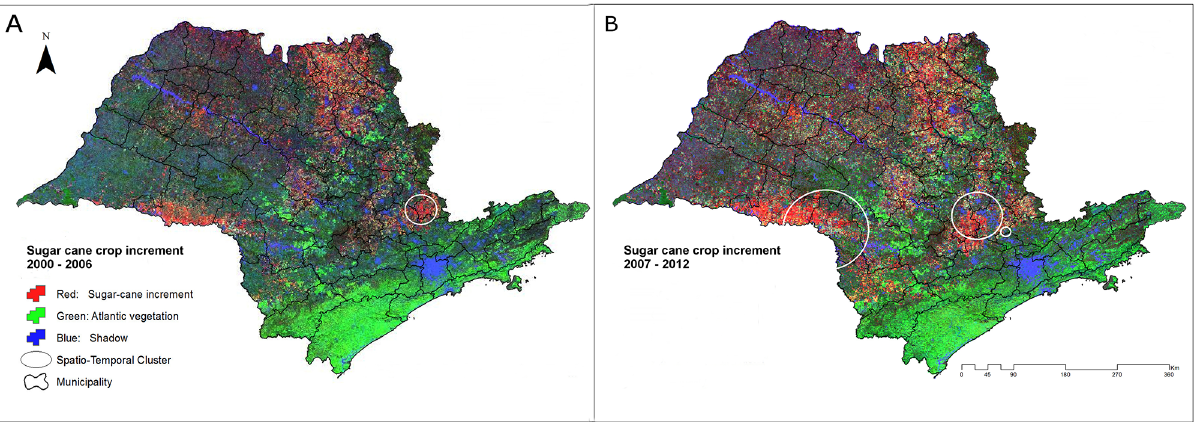
Fig 2. Linear unmixing model result showing the pixel abundance of the endmembers selected from the state of S ã o Paulo. (A) 2000 – 2006. (B) 2007 – 2012. Atlantic vegetation is represented in green, sugarcane crops in red and substrates in the blue